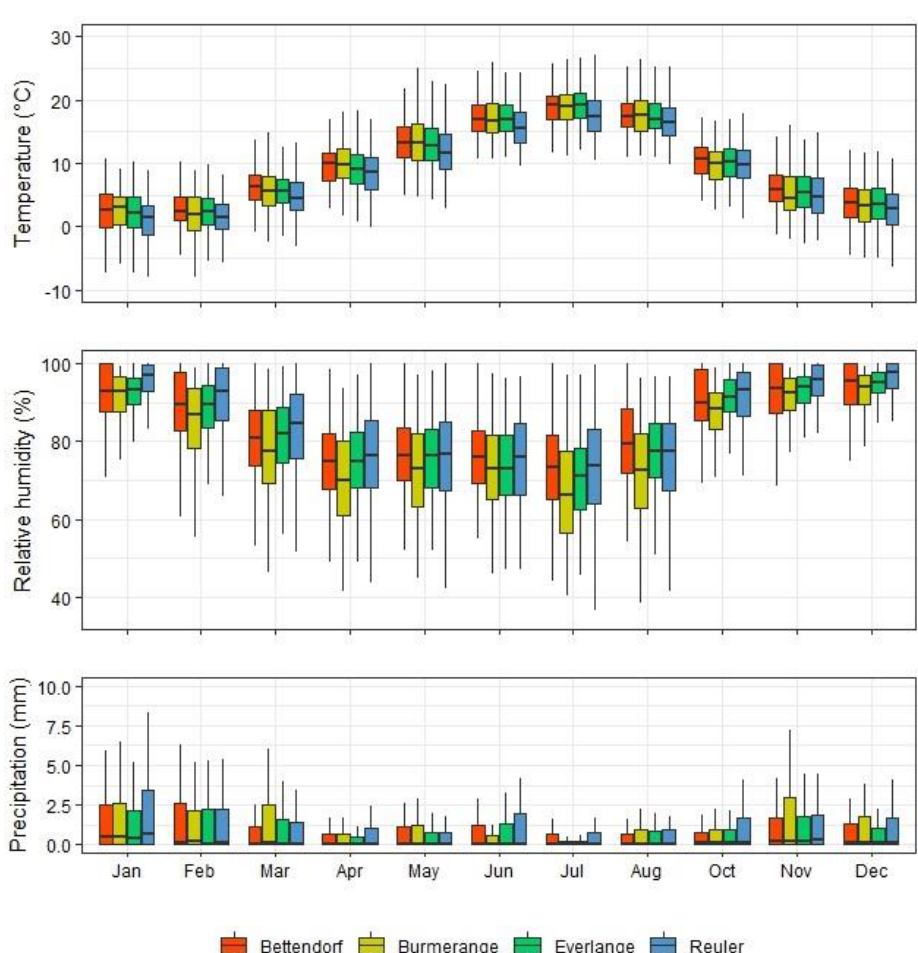
Figure 1. Distribution and variability of daily mean air temperature, relative humidity and precipitation during the 2014–2019 period at the study sites in the Grand-Duchy of Luxembourg. For a given site, the boxplot represents the distribution of daily meteorological variables for each month over the 2014–2019 period. The top and bottom of the box represent the 75th and 25th percentiles, respectively; the solid line indicates the median. The whiskers on the top and bottom represent the largest and smallest values within 1.5 times interquartile range above the third and first quantiles,